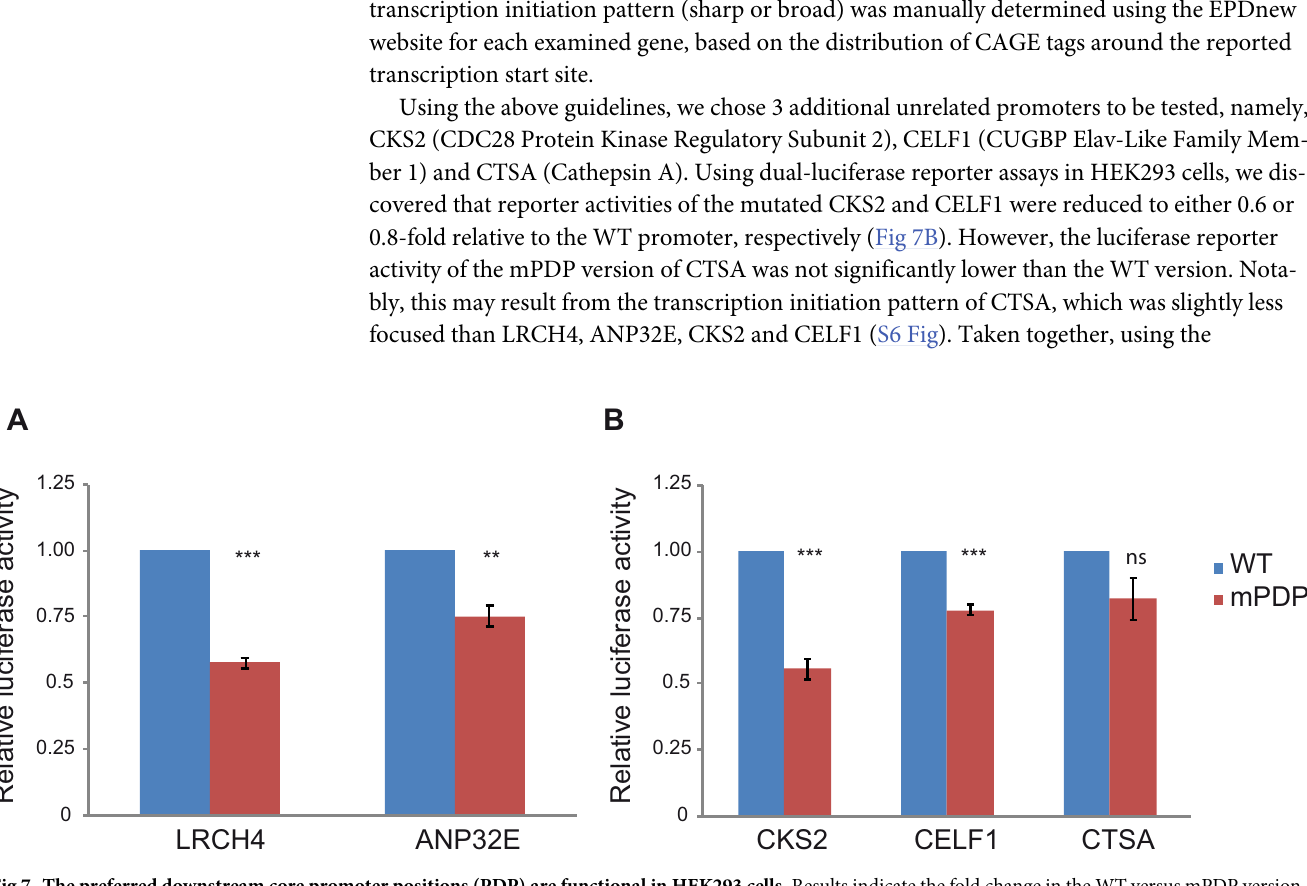
applied a new additional cut-off expression levels criterion (based on HEK293 CAGE data gen- erated by FANTOM5 consortium) - higher than or similar to those of LRCH4 - to select candi- date promoters that would likely be expressed in our experimental system. Moreover, transcription initiation pattern (sharp or broad) was manually determined using the EPDnew website for each examined gene, based on the distribution of CAGE tags around the reported transcription start site. Using the above guidelines, we chose 3 additional unrelated promoters to be tested, namely,